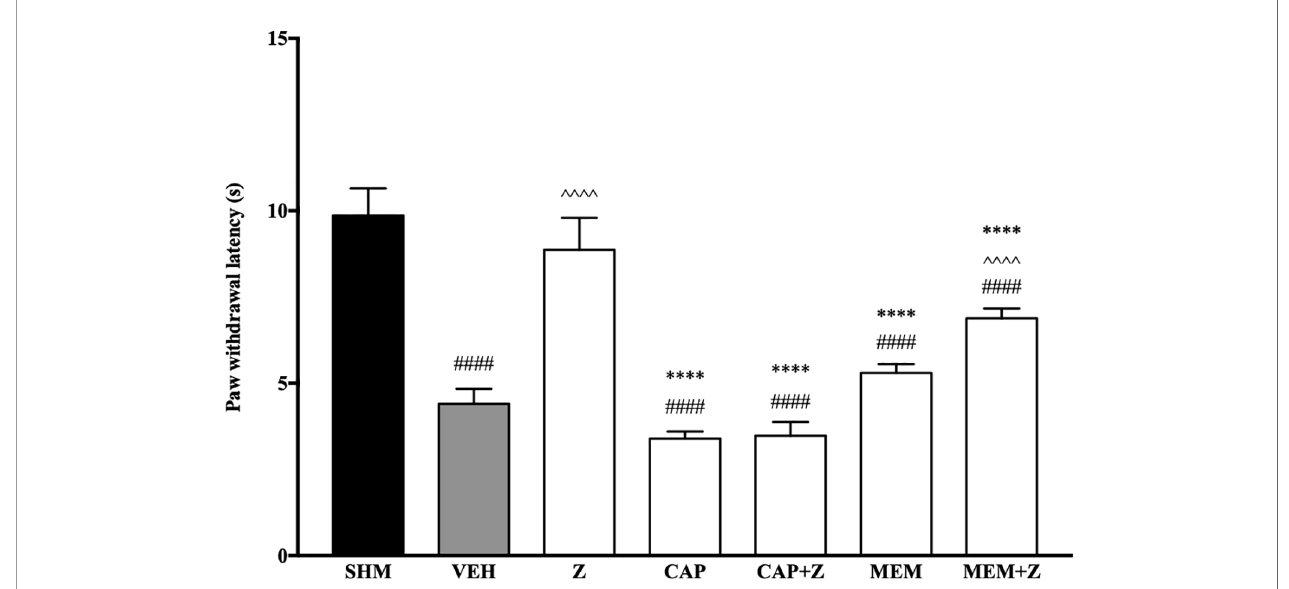
FIGURE 9 | Effect of capsazepine (TRPV1 antagonist) and memantine (NMDA antagonist) pre-treatment on zerumbone against thermal hyperalgesia in CCI-induced neuropathic pain mice. Data are presented as mean ± SEM (n= 6). #### p < 0.0001 as compared to sham, ^^^^ p < 0.0001 as compared to vehicleand **** p < 0.0001 as compared to zerumbone-treatedgroup.SHM(Sham); VEH (Vehicle, 10 mL/kg i.p.);Z (Zerumbone, 10 mg/kg i.p.);CAP (Capsazepine, 10 mg/kg i.p.);MEM (Memantine, 10 mg/kg i.p.).